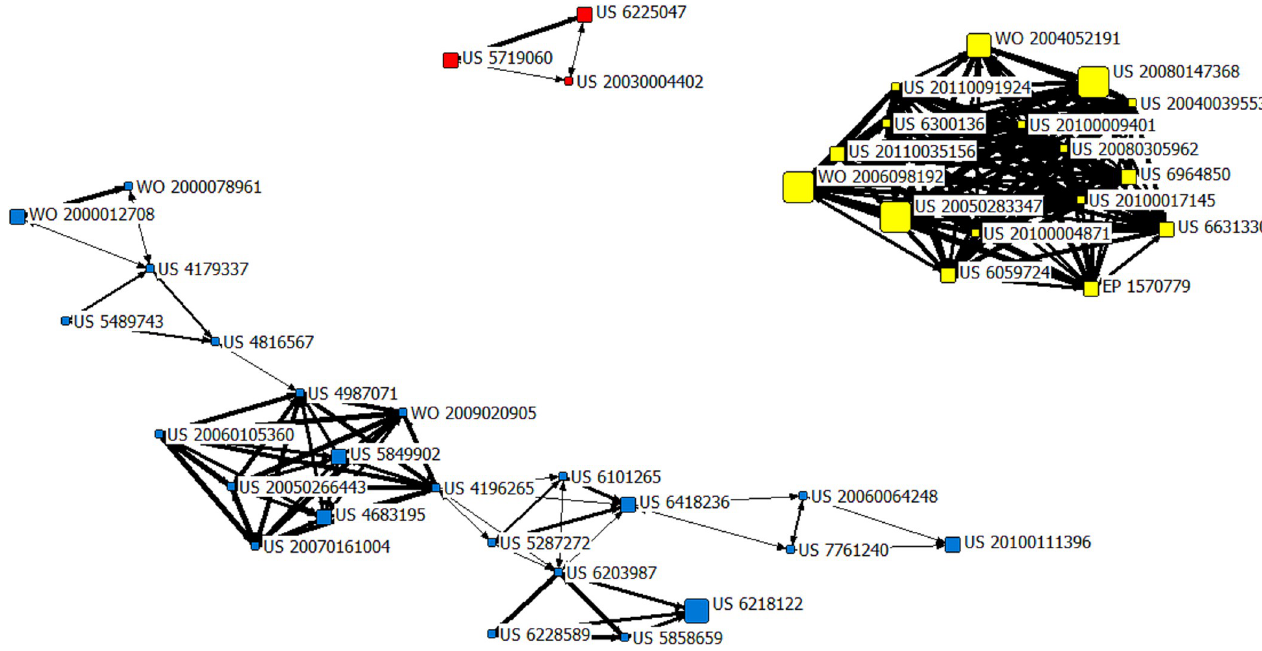
Fig 4. The patent co-citation network of the field of AI-assisted pathology from 2001 to 2015. Note: The subnetwork 1 is with the red nodes, the subnetwork 2 with the yellow nodes, and the subnetwork 3 with the blue nodes.